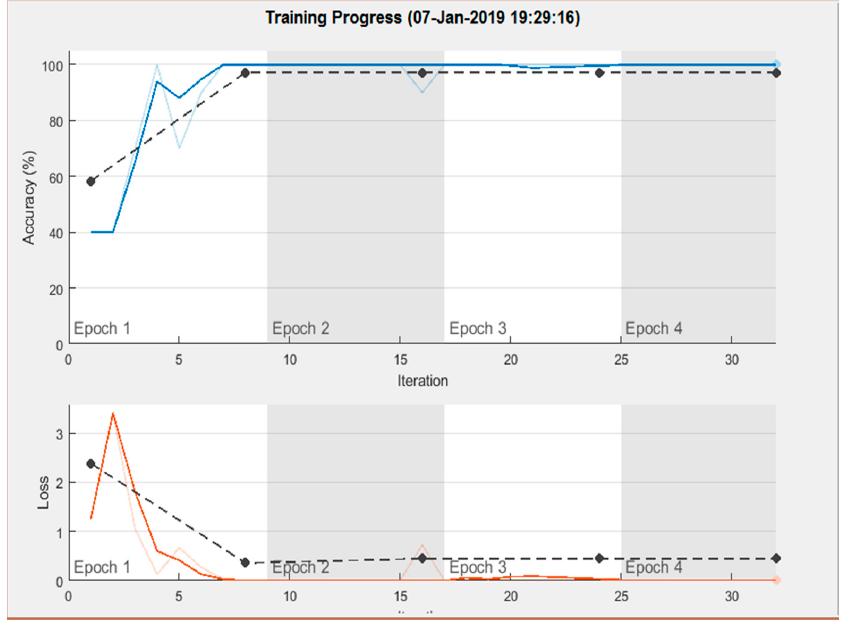
Figure 7. Training progress report.